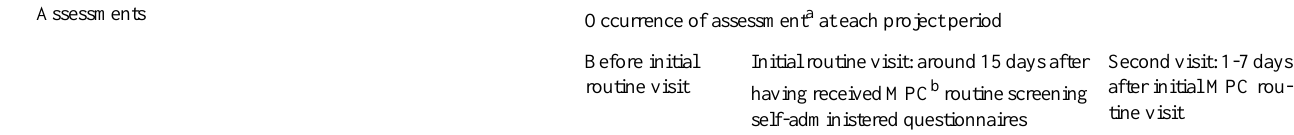
Table 2. Schedule of assessments (flow of research project).